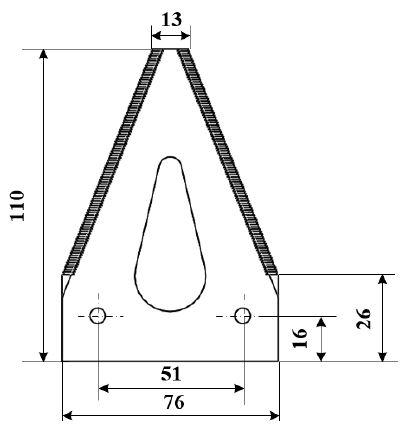
Figure 4. Selecting the fixed blade.